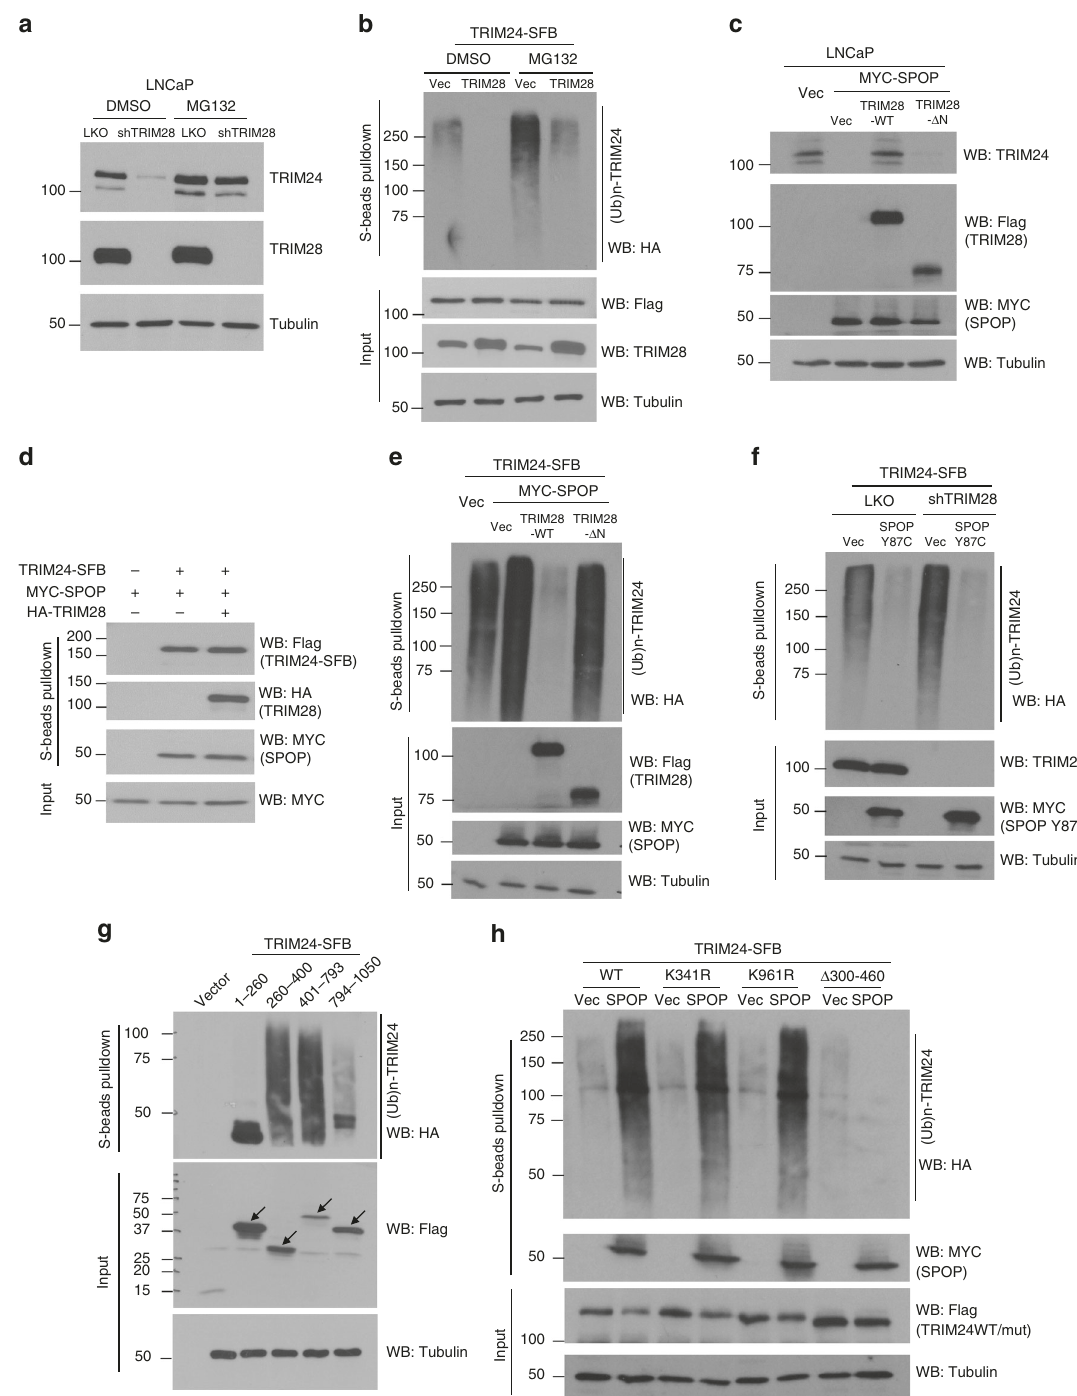
TRIM28 protects TRIM24 from SPOP-mediated degradation . To determine how TRIM28 stabilizes TRIM24 protein, we treated control or TRIM28-knockdown LNCaP cells with DMSO or proteasome inhibitor MG132. Western blot analysis showed that MG132 blocked TRIM24 protein degradation in TRIM28- knockdown cells (Fig. 3a), suggesting an ubiquitin-proteasome- mediated pathway. To determine whether TRIM28 prevents TRIM24 protein ubiquitination, we overexpressed control and TRIM28 in 293T cells that were co-transfected with